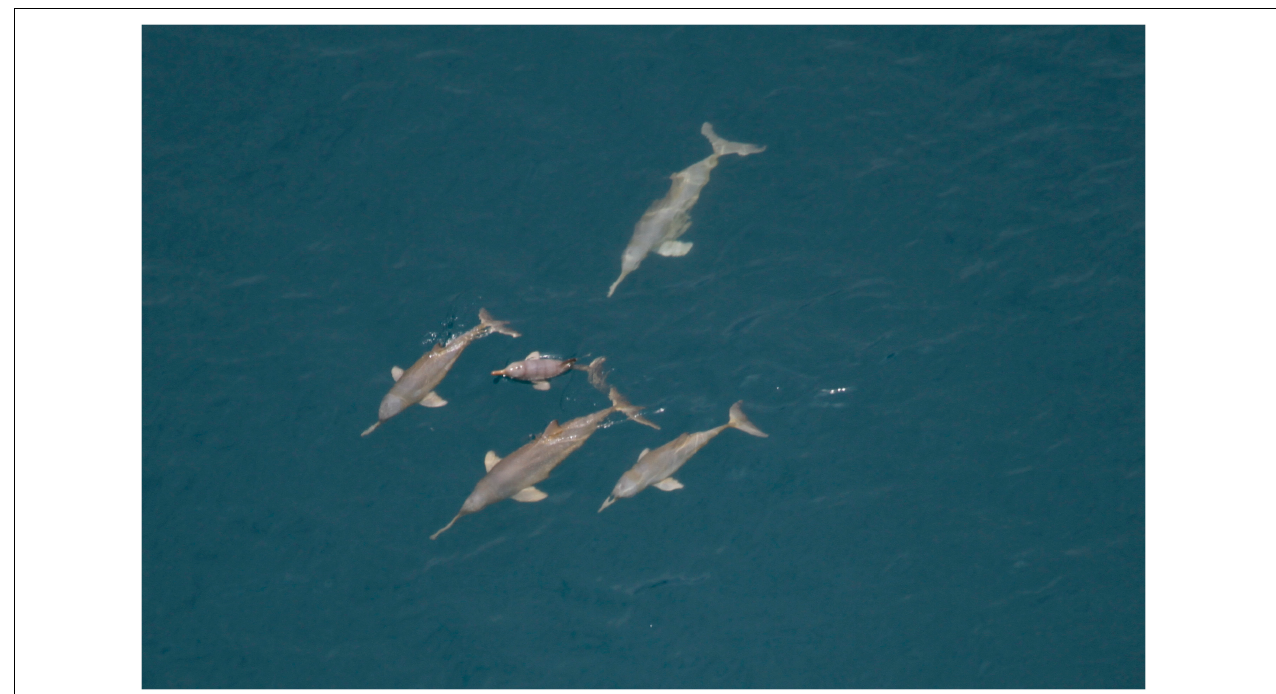
FIGURE 1 | Group of franciscanas including two adults (longer beaks), two likely juveniles (shorter beaks) and a newborn